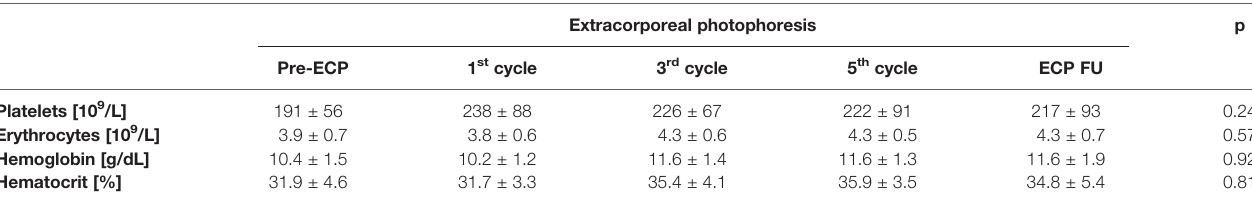
TABLE 1 | Blood parameters of patients treated with extracorporeal photopheresis. Extracorporeal photophoresis